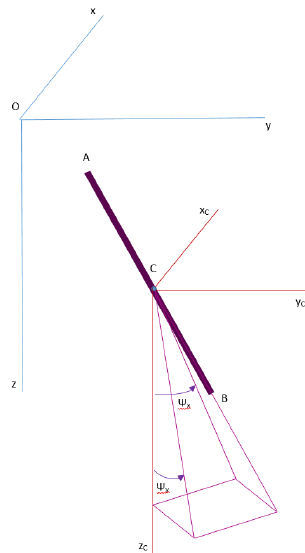
Figure 21. Scheme of free movement of the beam AB after the breakage of the second branch of the rope According to formulas (36) and (37):